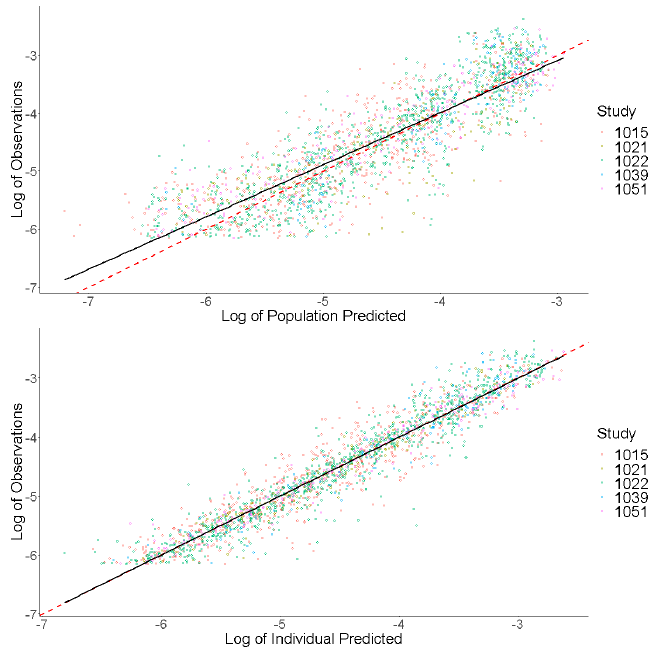
Figure 5. Prediction-Based Diagnostics for Dacomitinib Final Model. Observed concentrations (log